Question: Sum up the contents of this chart in one sentence.
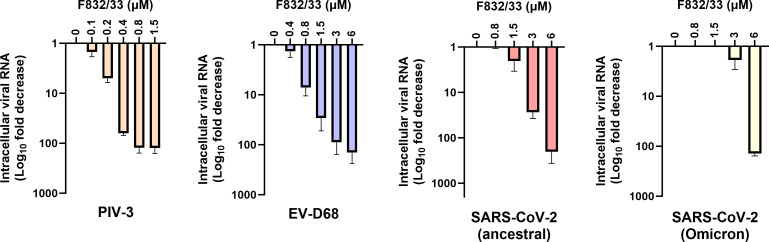
Answer: Reduction of intracellular viral RNA levels of four respiratory viruses (PIV-3, EV-D68, SARS-CoV-2 ancestral strain, and SARS-CoV-2 Omicron variant) by increasing concentrations of F832/33 in appropriate immortalized cell lines (PIV-3 and ancestral SARS-CoV-2: Vero cells; EV-D68: A549 cells; SARS-CoV-2 Omicron: VeroTMPRSS2 cells). Data are shown as the mean ± SD from at least two independent experiments.